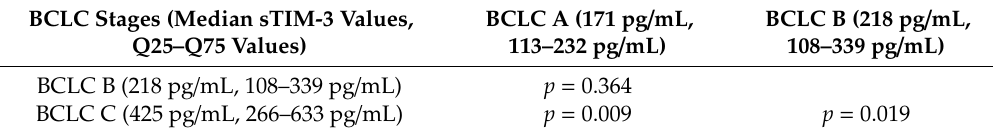
Figure 1. Baseline sTIM-3 values according to BCLC stage in 46 HCC patients. Kruskall–Wallis test was applied to compare median values per BCLC stage A, B and C. BCLC; Barcelona Clinic Liver Cancer, sTIM-3; serum T-cell immunoglobulin and mucin domain-3, HCC; Hepatocellular carcinoma. Table 2. Comparison of sTIM-3 values between pairs of BCLC groups. Dunn test was performed for post-hoc analysis. Patients with BCLC 0 and D were excluded due to small number of patients and outliers were also excluded from the analysis. Statistically significant differences are in bold. BCLC;